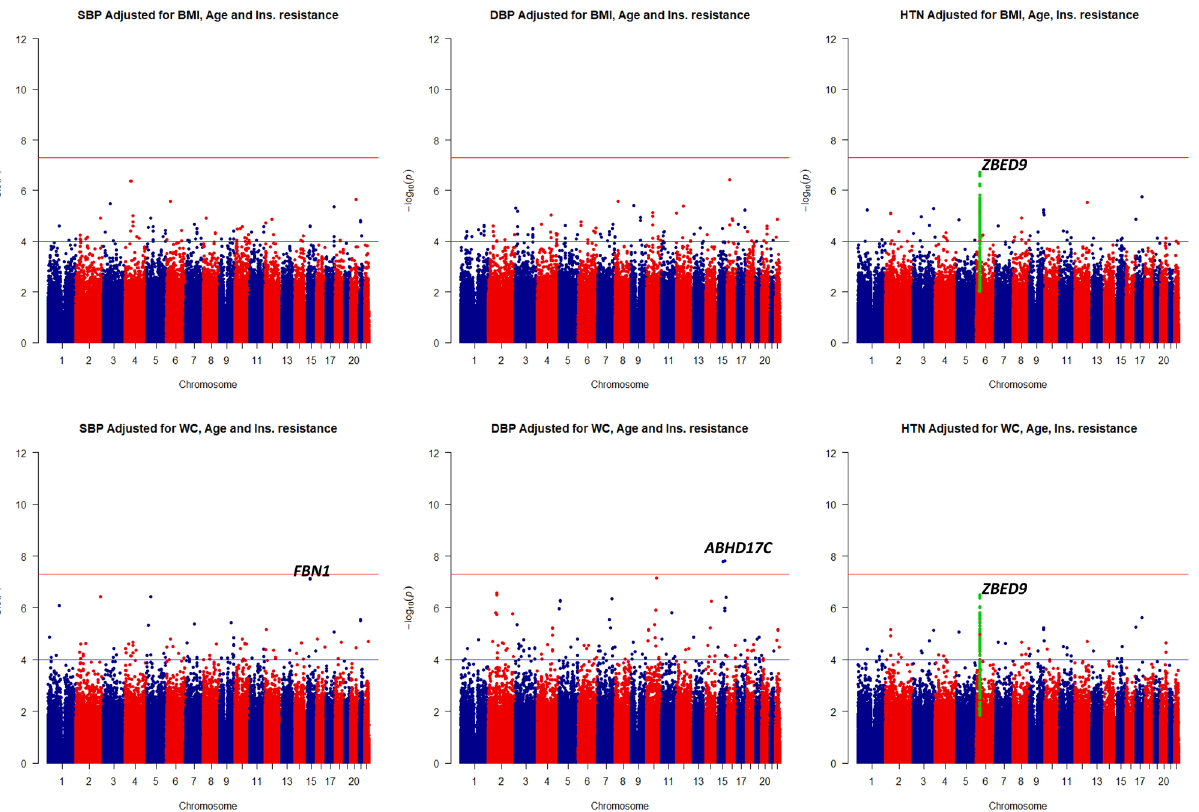
Figure 1. Manhattan plots of BP quantitative and binary traits, adjusted for two covariate sets of BMI and